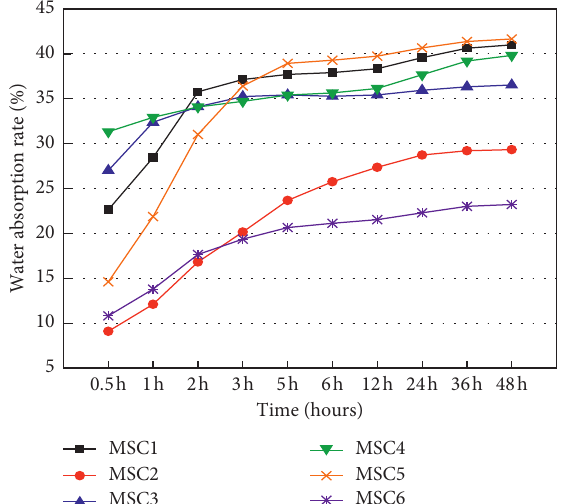
Figure 7: Test results of water absorption of